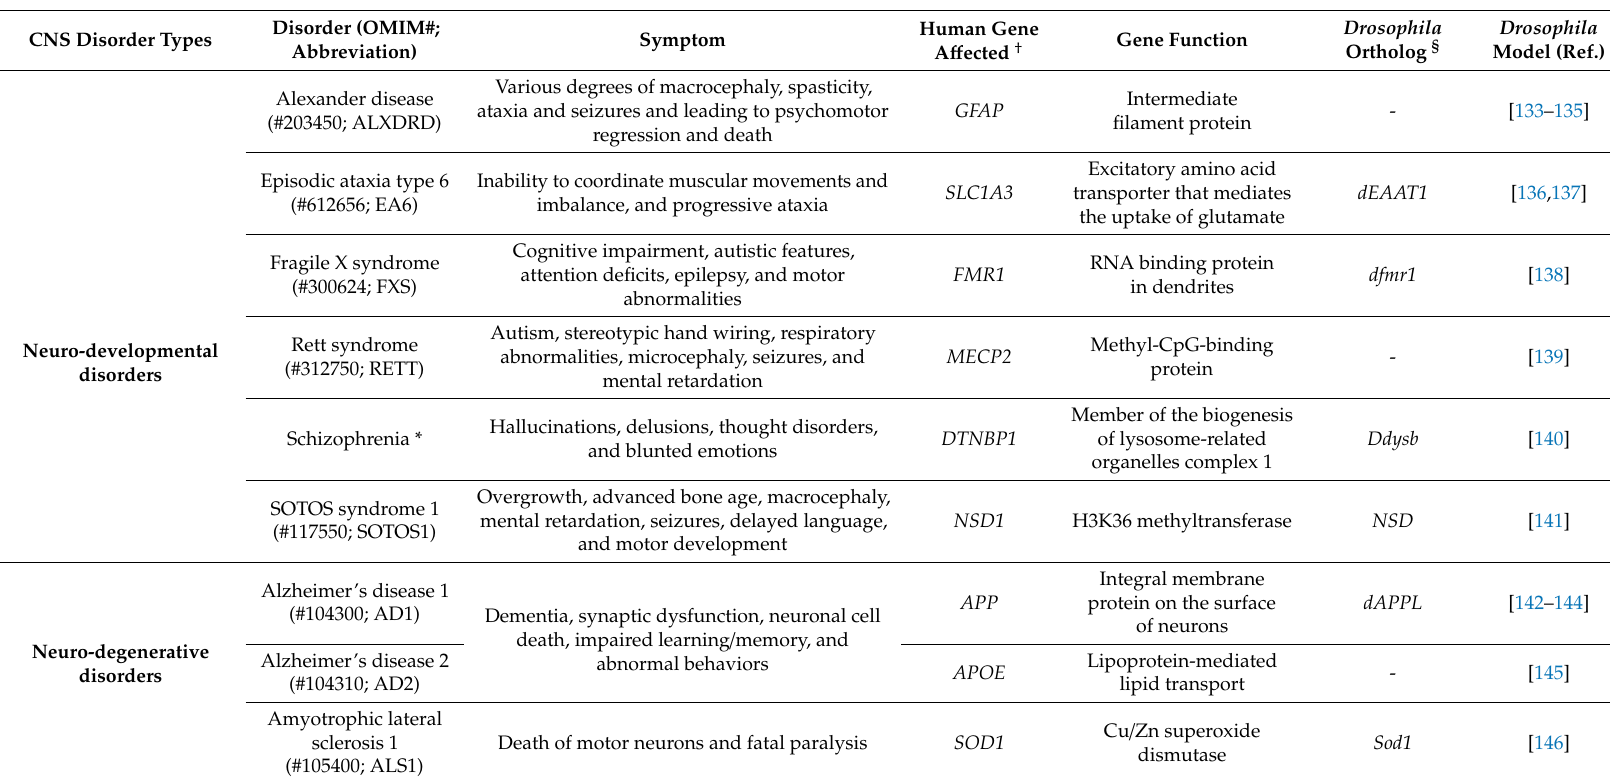
Table 1. List of CNS disorders summarized in this review and their Drosophila models to study the roles of glial